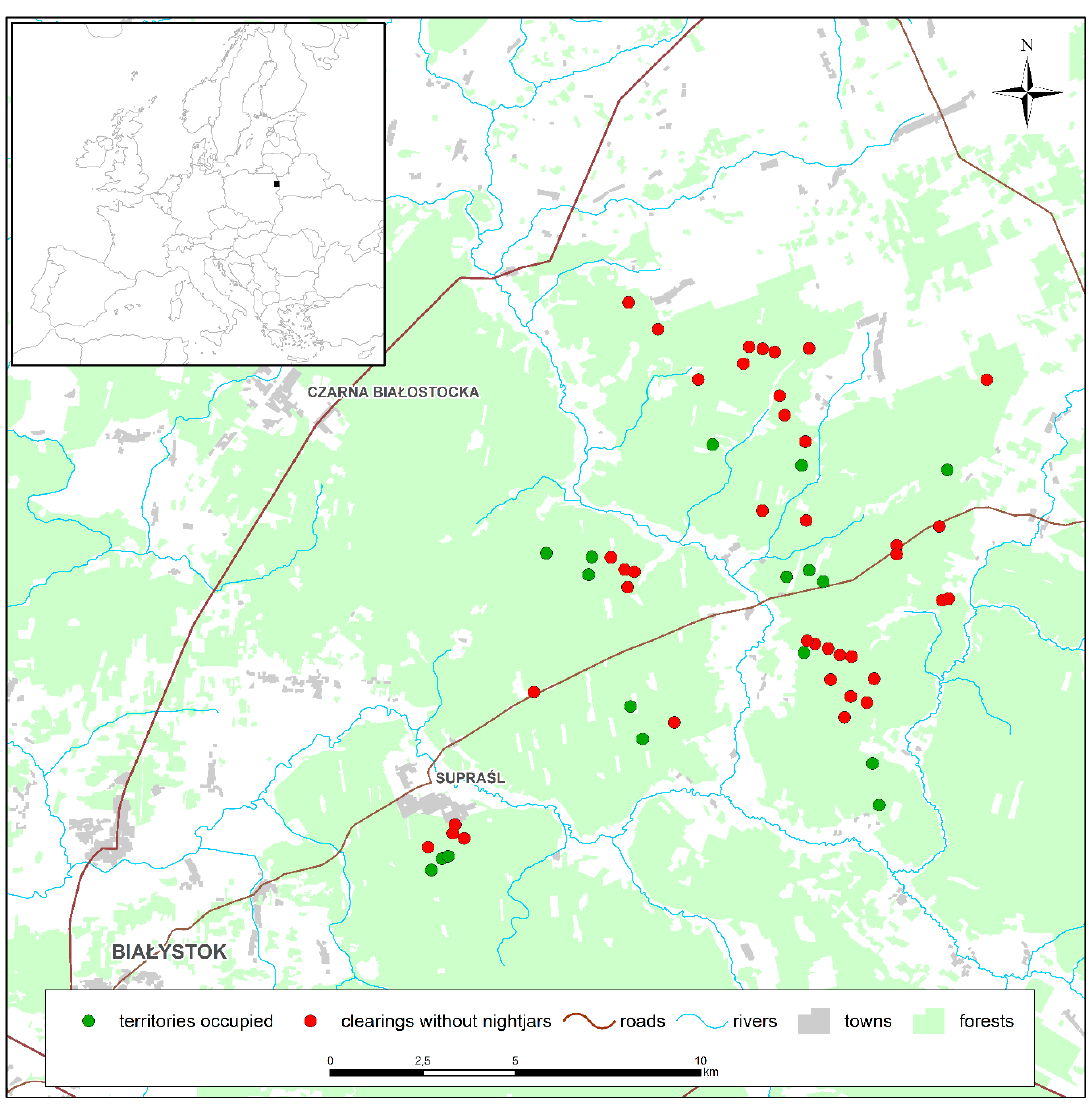
Figure 1. The study area and the occurrence of Nightjars Caprimulgus europaeus.